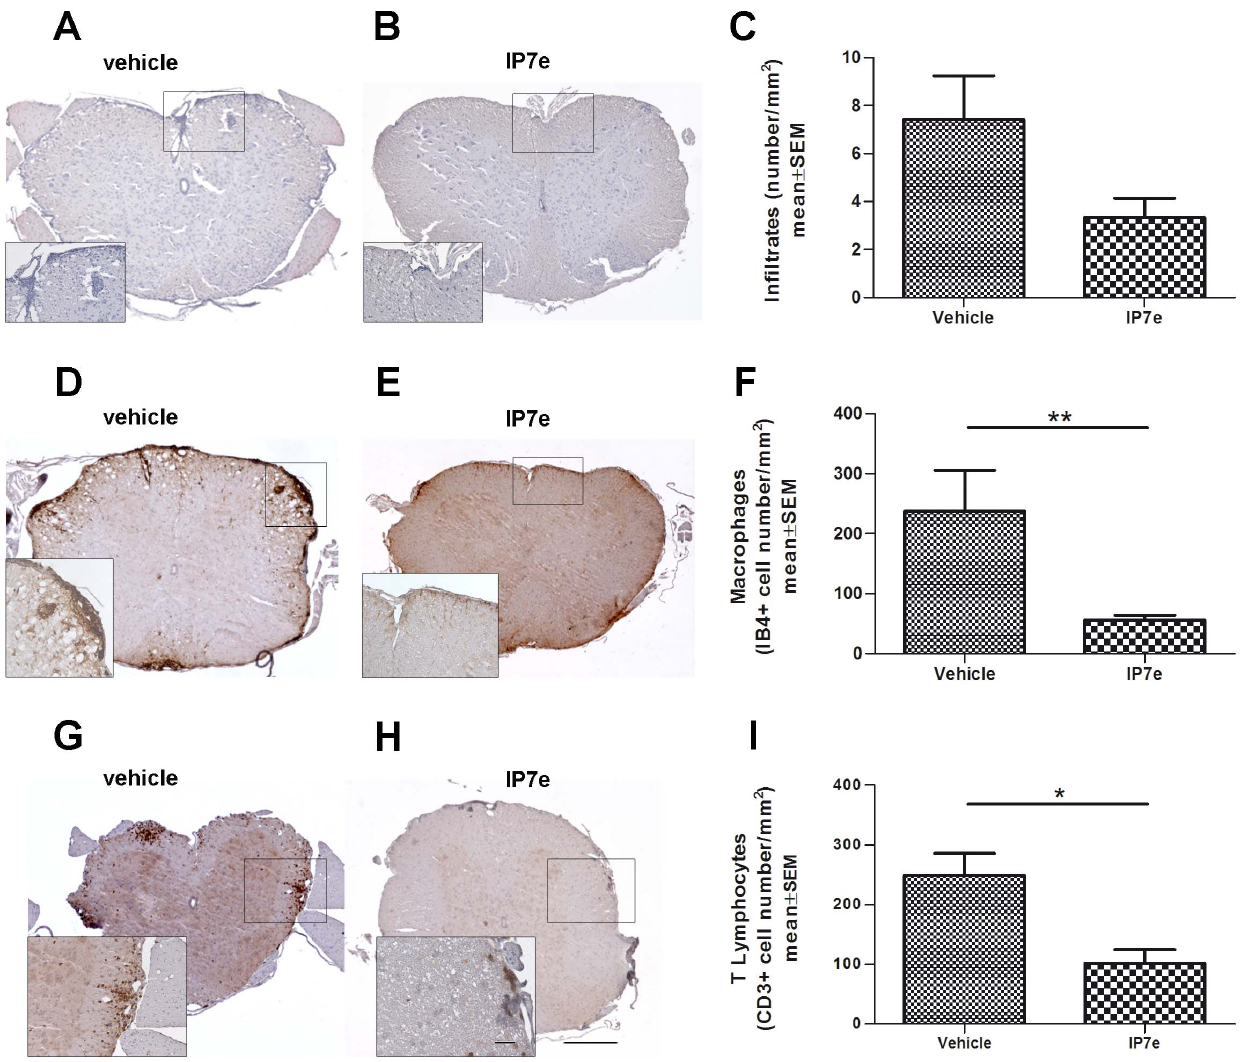
Figure 3. Preventive administration of IP7e reduces the number of macrophages and T lymphocytes infiltrated in the spinal cord of mice with EAE. Representative images of coronal sections of the spinal cord of IP7e (B, E, H) and vehicle (A, D, G) –treated EAE mice. The presence of perivascular inflammatory infiltrates (A, B), macrophages (D, E) and T lymphocytes (G, H) are evaluated using respectively Hematoxylin and Eosin staining and immunohistochemistry (IB4 + and CD3 + cells for macrophages and T lymphocytes, respectively) in the spinal cord of IP7e (n=5) and vehicle (n=5) -treated EAE mice. Calibration bars, 25 m m and 250 m m. Quantification shows that the number per section of perivascular inflammatory infiltrates shows a tendency to decrease after IP7etreatment (C). Furthermore, the number per section of macrophages (F) and T lymphocytes (I) after IP7e treatment results significantly decreased compared to vehicle-treated mice. (Student’s t test, *: P , 0.05; **: P , 0.01). Data are expressed as mean 6 SEM. (IP7e; isoxazolo-pyridinone 7e, SEM; standard error of